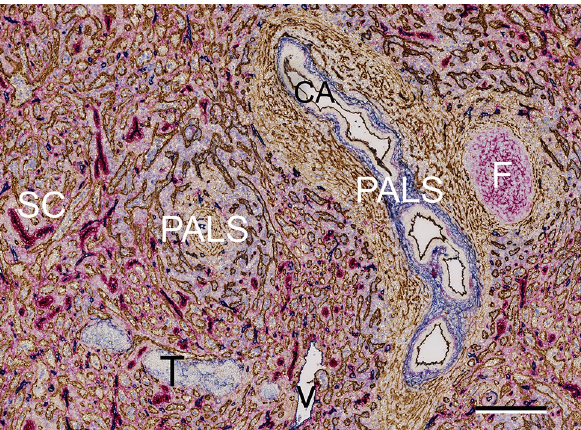
Figure 1. Overview of splenic microanatomy in a typical section (No. 1, outside ROIs) after sequential staining for CD141 (brown), CD34 (blue) and CD271 (red). F: follicle supported by CD271 + FDCs; PALS: periarterial lymphatic sheath (T-cell zone) with CD141 + T-zone reticular cells; CA: central artery with CD141 + CD34 + endothelial and CD34 + adventitial cells; V: red pulp venule/vein; T: trabecula with CD34 + superficial fibroblasts; SC: sheathed capillary with CD271 + stromal sheath cells. Note that perifollicular and peri-PALS sinuses are more darkly stained because of co-expression of CD34 and CD141. Scale bar = 200